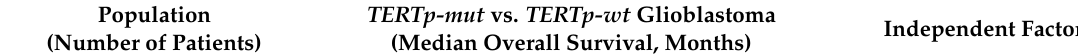
Table 2. Prognostic impact of TERTp mutations in